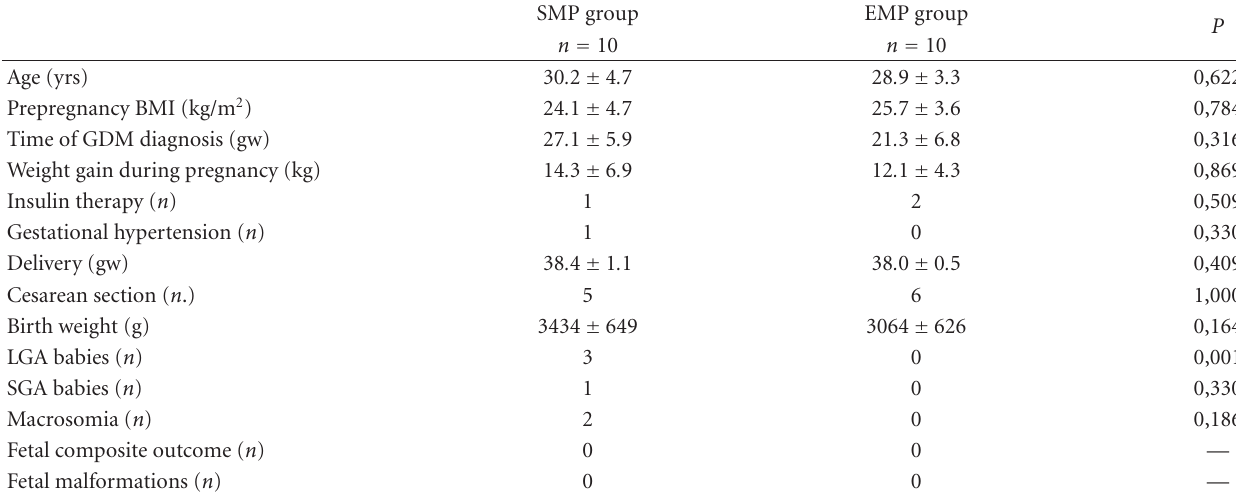
Table 2: Clinical and metabolic characteristics and pregnancy outcome of the subjects under